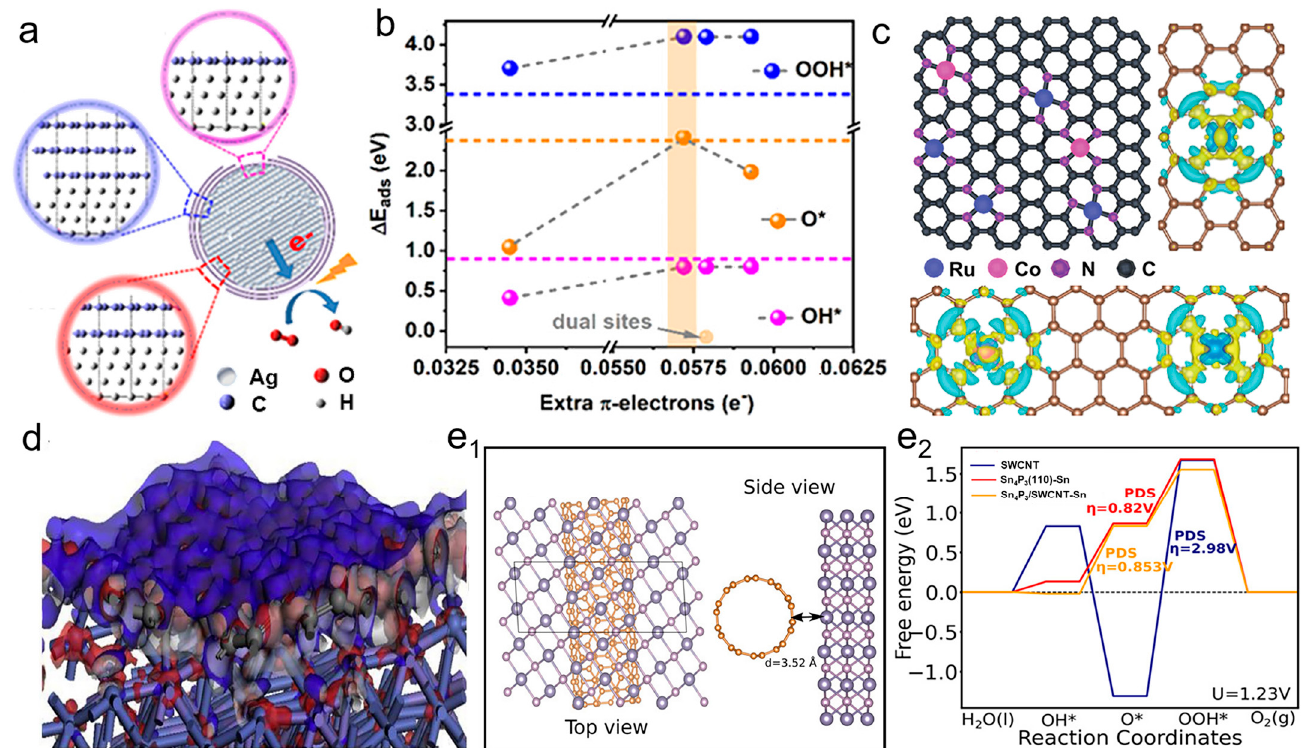
Figure 3. ( a ) The interface profile of Ag core and graphene shell. Reproduced with permission of [28], copyright 2019 ACS Publishers. ( b ) Relationship between Δ E ads and the extra π –electrons. ( c ) Differential charge density of Ru–N–C and Ru/Co–N–C. Reproduced with permission of [29], copyright 2022 John Wiley and Son. ( d ) The electron transfer between electron density difference of FeNi 3 and NC. Reproduced with permission of [30], copyright 2020 Elsevier. ( e 1 ) Sn 4 P 3 –SWCNT interaction schematic diagram. ( e 2 ) Gibbs free energy of O-intermediates at Sn and P sites. Reproduced with permission of [31], copyright 2022 ACS Publishers.